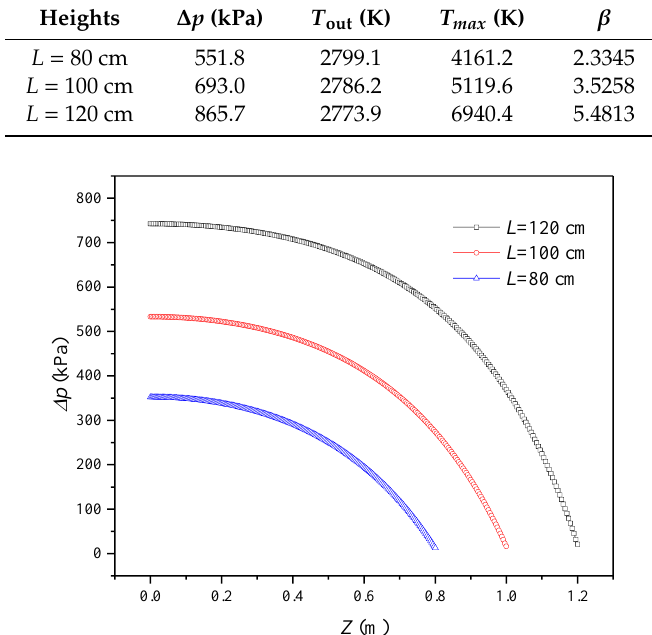
Figure 10. Pressure profile within the hot gas channel along the axial direction in the PBRs of various core